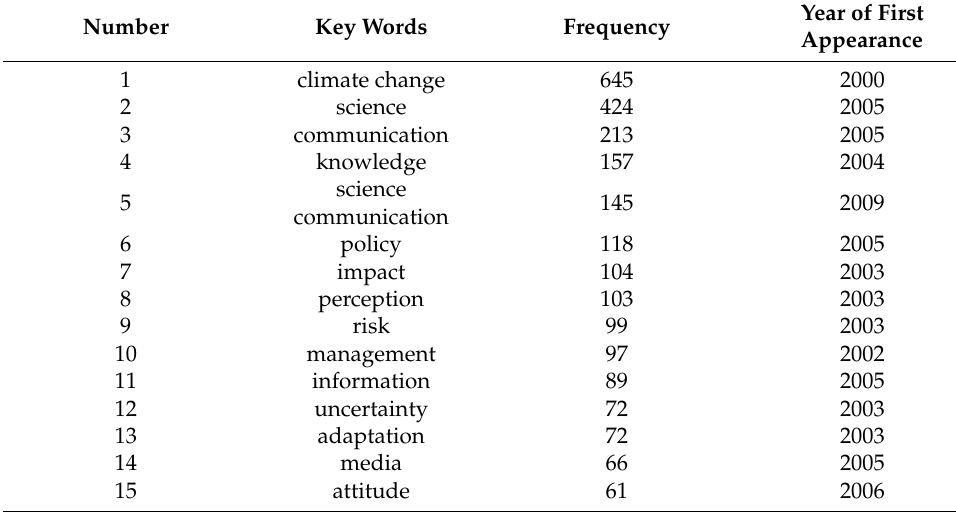
Figure 6. Co-occurrence of keywords. Table 4. Statistics of the Top 15 keywords.